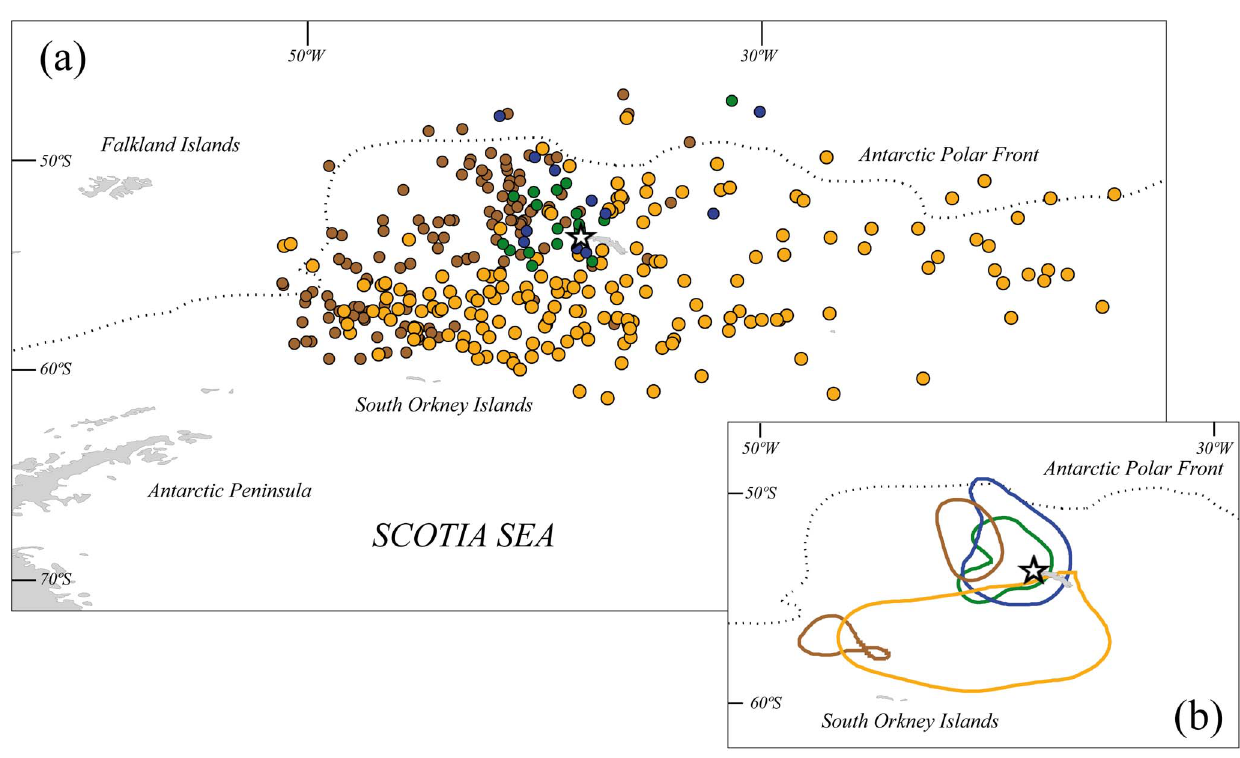
Figure 1. Spatial distribution of foraging areas. (a) Locations and (b) core areas (50% kernel contours) of 10 Antarctic prions (brown symbols & contours), 12 blue petrels (orange symbols & contours), 9 common diving petrels (blue symbols & contours) and 8 South Georgian diving petrels (green symbols & contours) tracked using geolocators during incubation at Bird Island, South Georgia in summer 2010/11. The white star indicates the position of the colony.